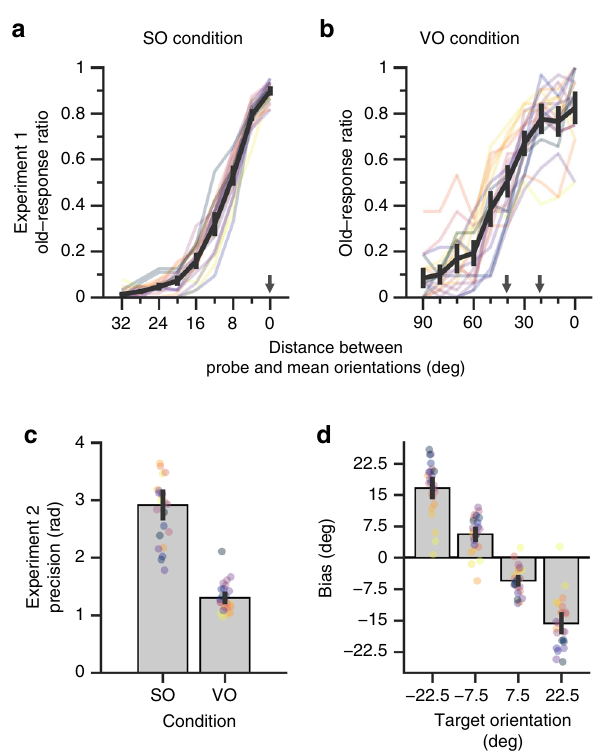
Fig. 2 Behavioral results illustrating participants ’ representations of target and mean orientations. a Participants precisely represented a single orientation in the SO condition of Experiment 1. The x -axis depicts the distance between probe orientation and stimulus orientation, and the y -axis shows the proportion of “ old ” responses. b Participants ’ represented mean orientations. The x -axis and y -axis are the same as Fig. 2a. c Participants reported orientations more precisely in the SO condition than in the VO condition. The x -axis shows conditions, and the y -axis shows mean precision of response errors. d Participants ’ response errors were systematically biased towards mean orientations. The x -axis shows target orientation, and the y axis shows the biases, calculated by mean response errors. All transparent colored lines and dots show the data of individual participants, and each color represents the same participant. All error bars represent 95% con fi dence intervals. SO — same orientation; VO — varied sensitivity. A higher, negative, or zero sensitivity corresponds to sharper, reversed, or no tuning for any orientations, respectively.